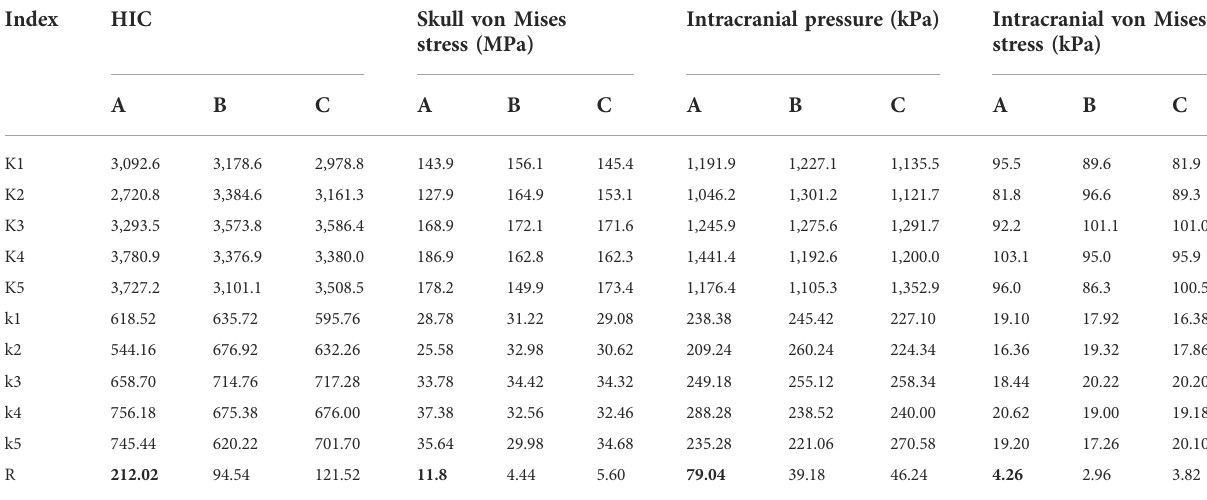
TABLE 3 Simulation results of the driver ’ s head injury value.